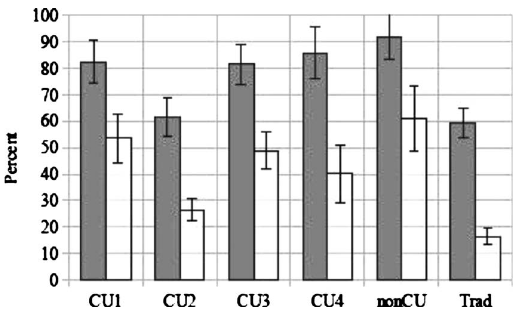
FIG. 3. Average score for both correctness (cid:1) gray bars (cid:2) and rea- soning (cid:1) white bars (cid:2) on CUE question 17.